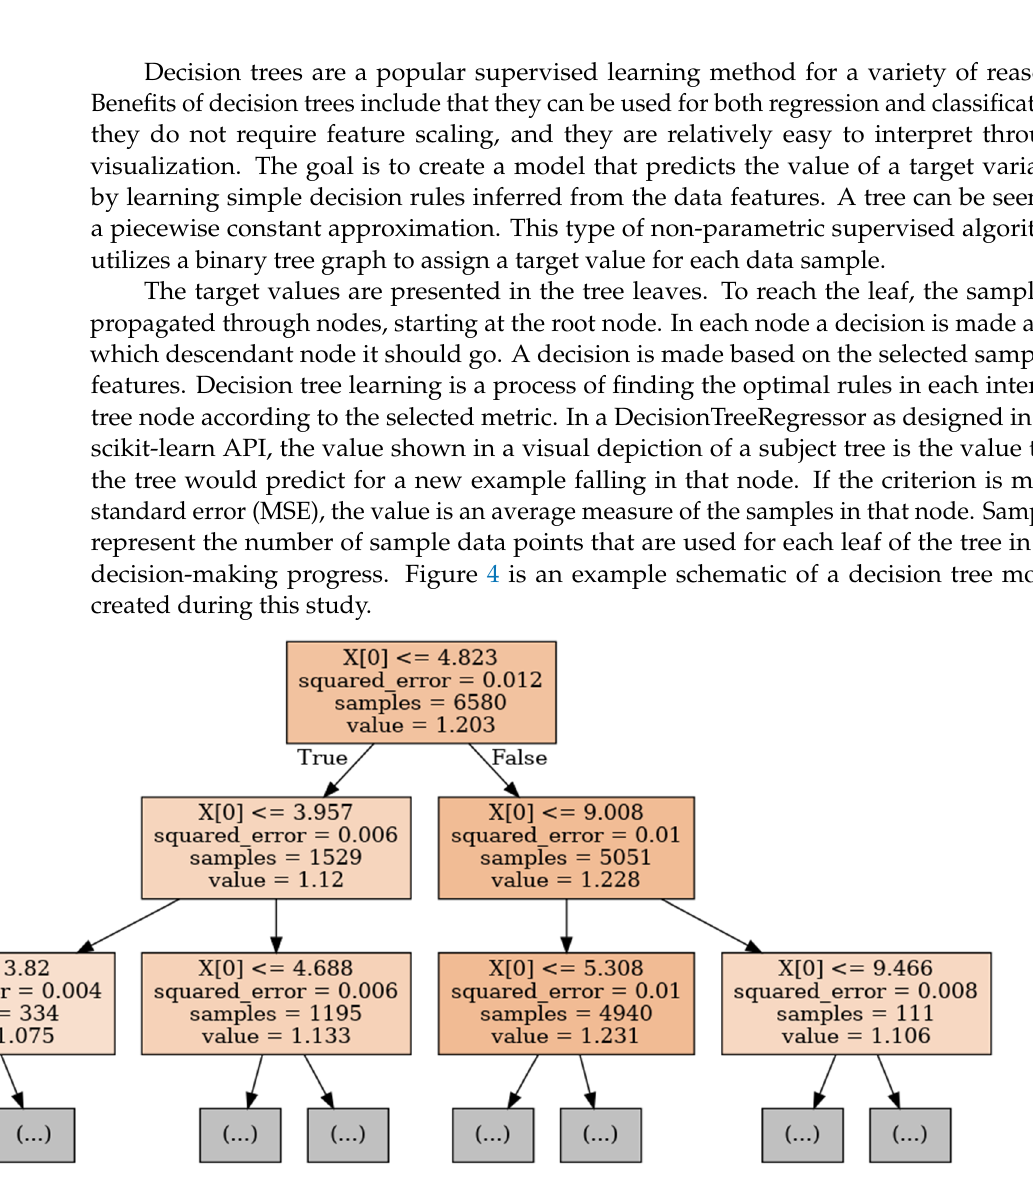
Figure 4. Example decision tree regressor nLw predictive model at 486 nm, built from VIIRS training datasets at the MOBY nLw in situ mooring.